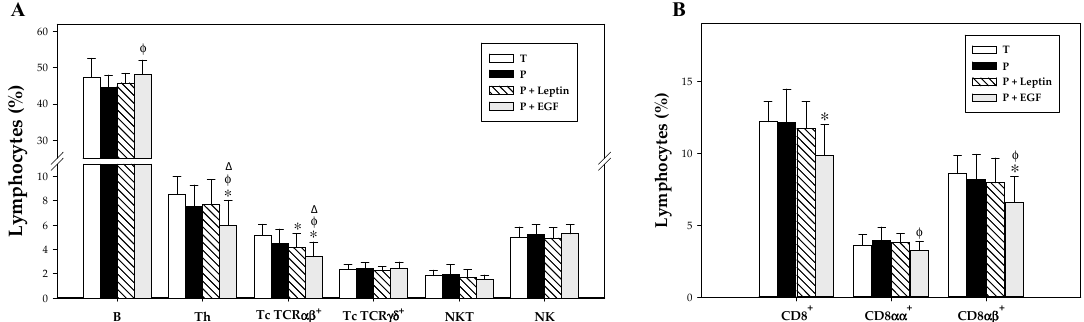
Figure 5. Main lymphocyte subsets ( A ) and CD8 + cells and their both forms (CD8 αα + and CD8 αβ + ) cell percentages ( B ) in the spleen from the four groups: Term (T), Preterm (P), P + Leptin, and P + epidermal growth factor (P + EGF) at day 17. The results are expressed as mean ± SD ( n = 8–12 pups / group). Statistical differences: * p < 0.05 versus T group; φ p < 0.05 versus P group; Δ p < 0.05 versus P+Leptin group.